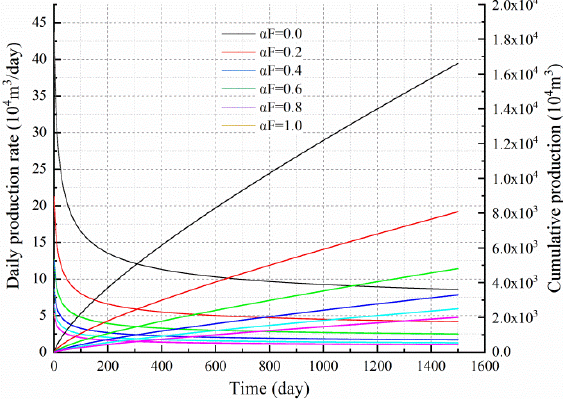
Figure 10. The effect of different matrix stress sensitivity coefficients on productivity. Figure 10. The e ff ect of di ff erent matrix stress sensitivity coe ffi cients on